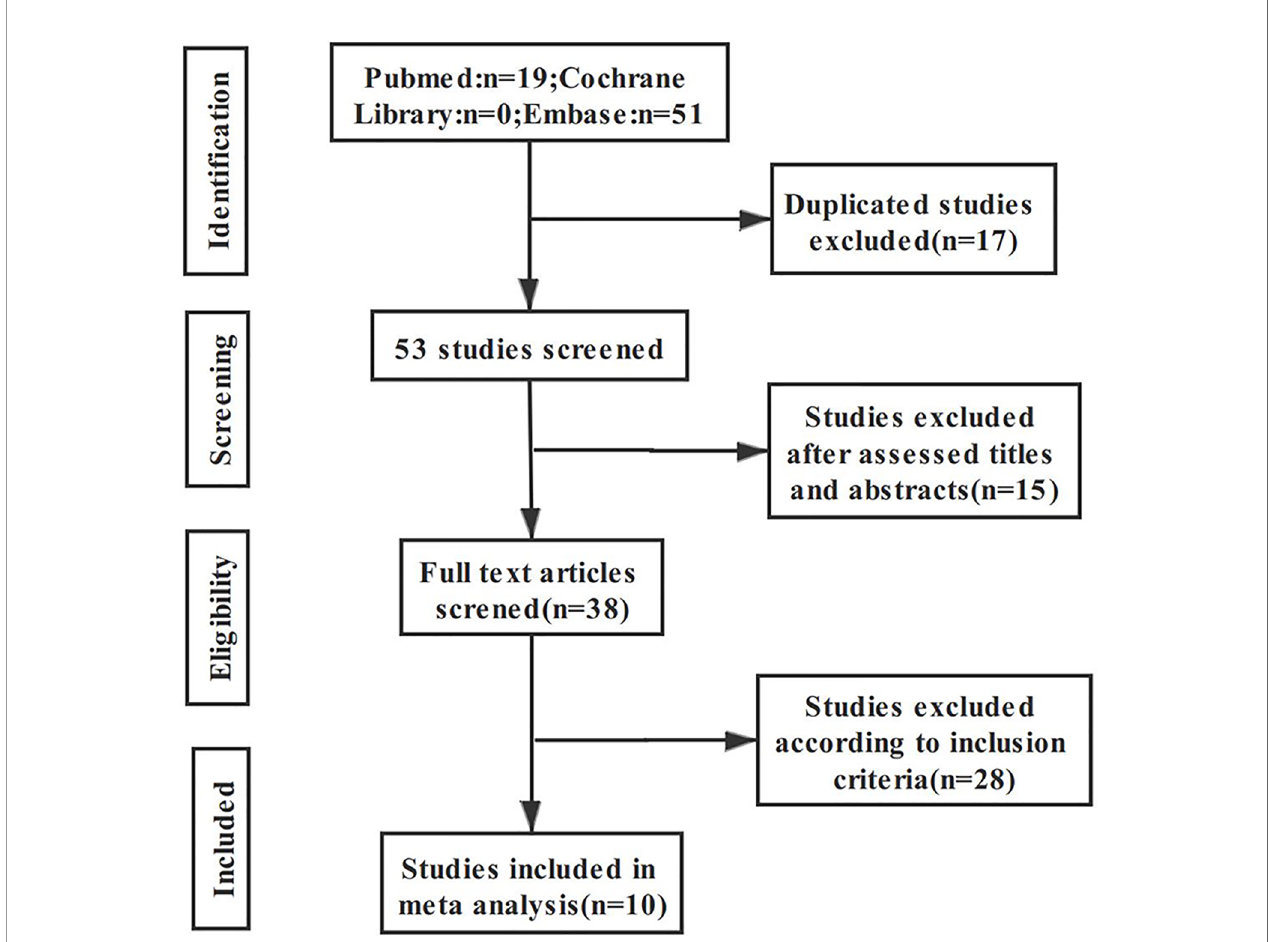
FIGURE 1 | The fl ow diagram of this